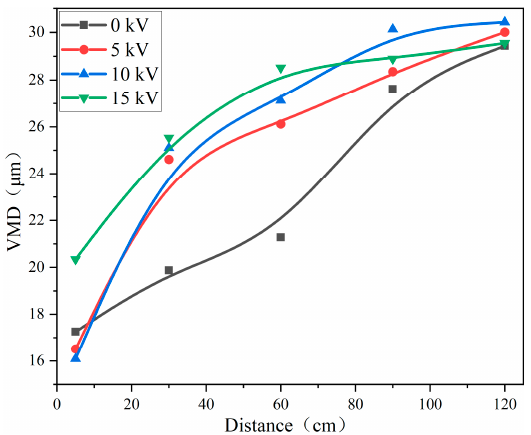
Figure 4. The water mist droplet size at di ff erent distances and charged voltages.